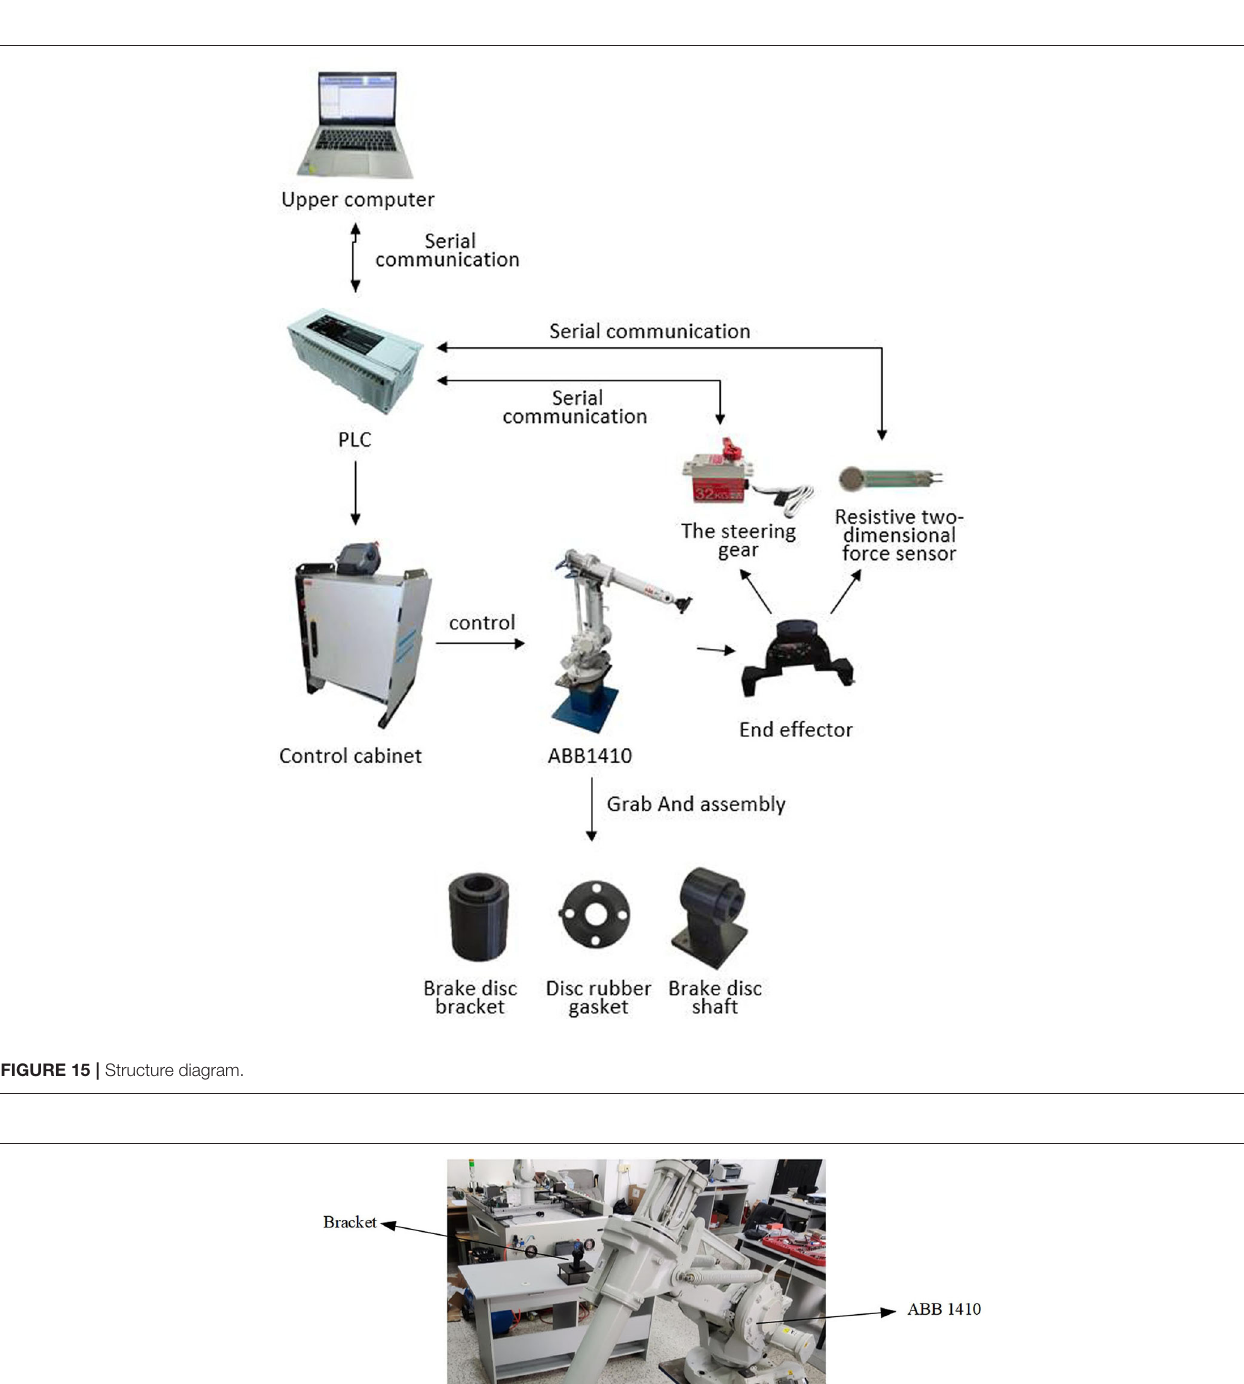
FIGURE 16 | Working position diagram of experimental grasping gasket.